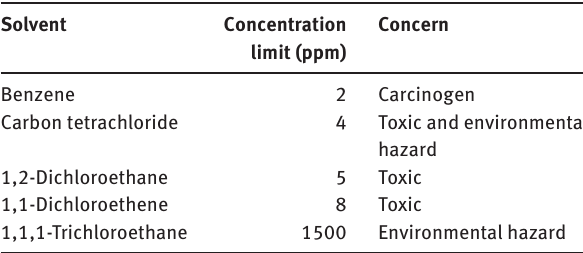
Table 6 Solvents in pharmaceutical products that should be limited (ICH